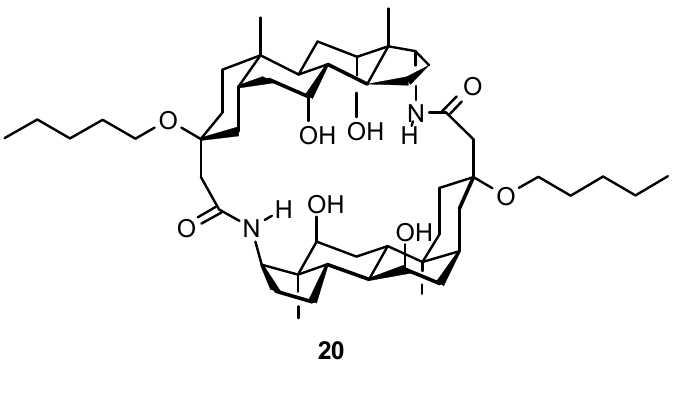
Figure 10. A steroid-based cryptand